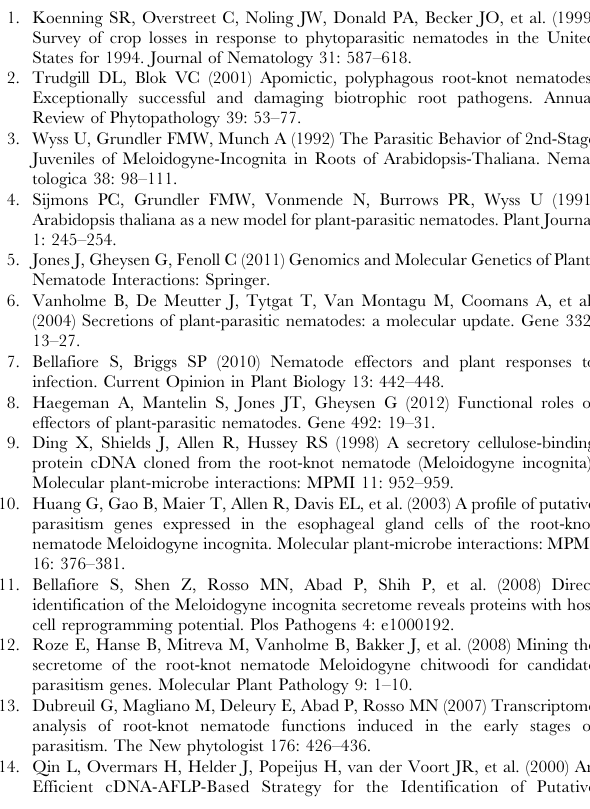
Table S3 Oligonucleotides used for qRT-PCR. Table S4 Mean D CT for statistical comparison. LSD = Least significant difference, degree of freedom (df) = 19 except for P16EF1 and P17AB3 (df =